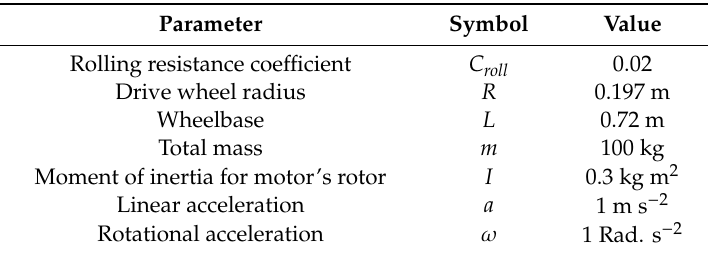
Table 1. The simulation parameters of the main